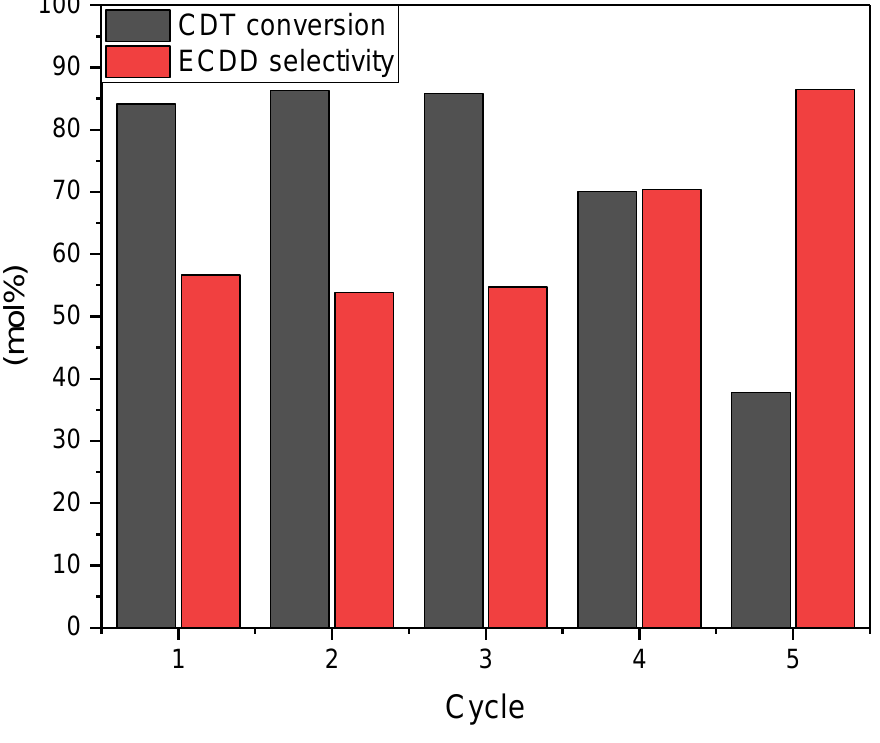
Figure 9. Graph showing changes in CDT conversion and selectivity of CDT to ECDD conversion as a function of the number of catalyst cycles. Process conditions: temperature, 60 ◦ C; solvent, i-PrOH, 90 wt%; CDT:H 2 O 2 molar ratio (60 wt% aqueous solution), 0.5; catalyst, W-SBA-15, 5 wt%.